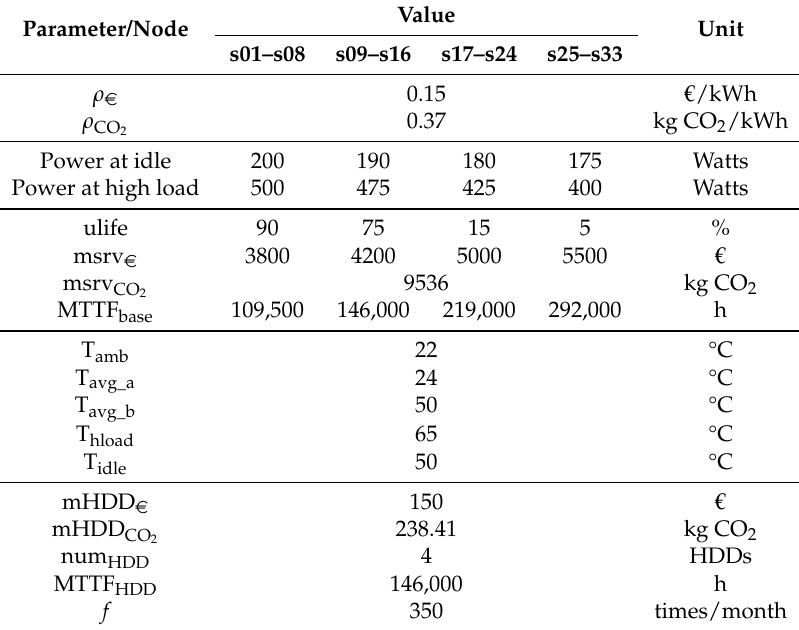
Table 2. Hardware parameters of the compute nodes used in the